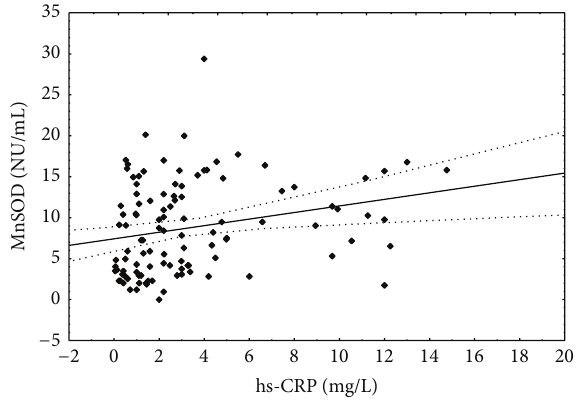
Figure 6: Correlation between hs-CRP concentration and man-